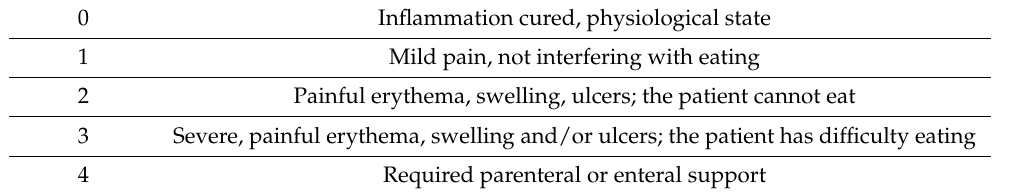
Table 2. Clinical scale for the assessment of inflammation severity by the WHO [20].